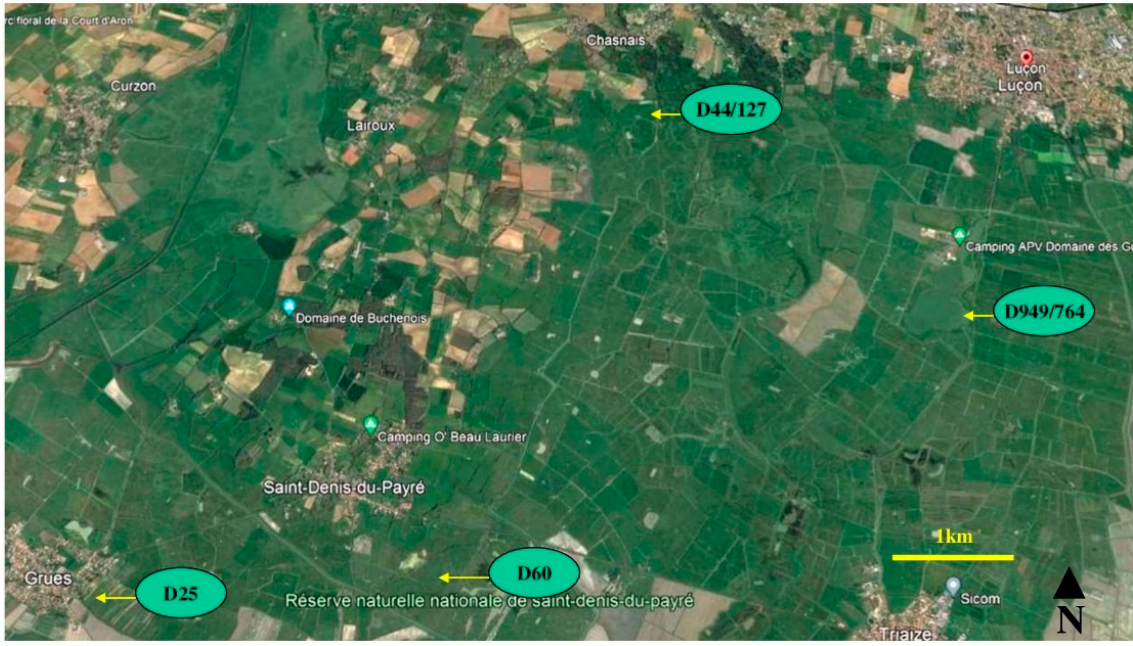
Figure 2. Map of the general study area with ponds shown in Figure 3 identified.